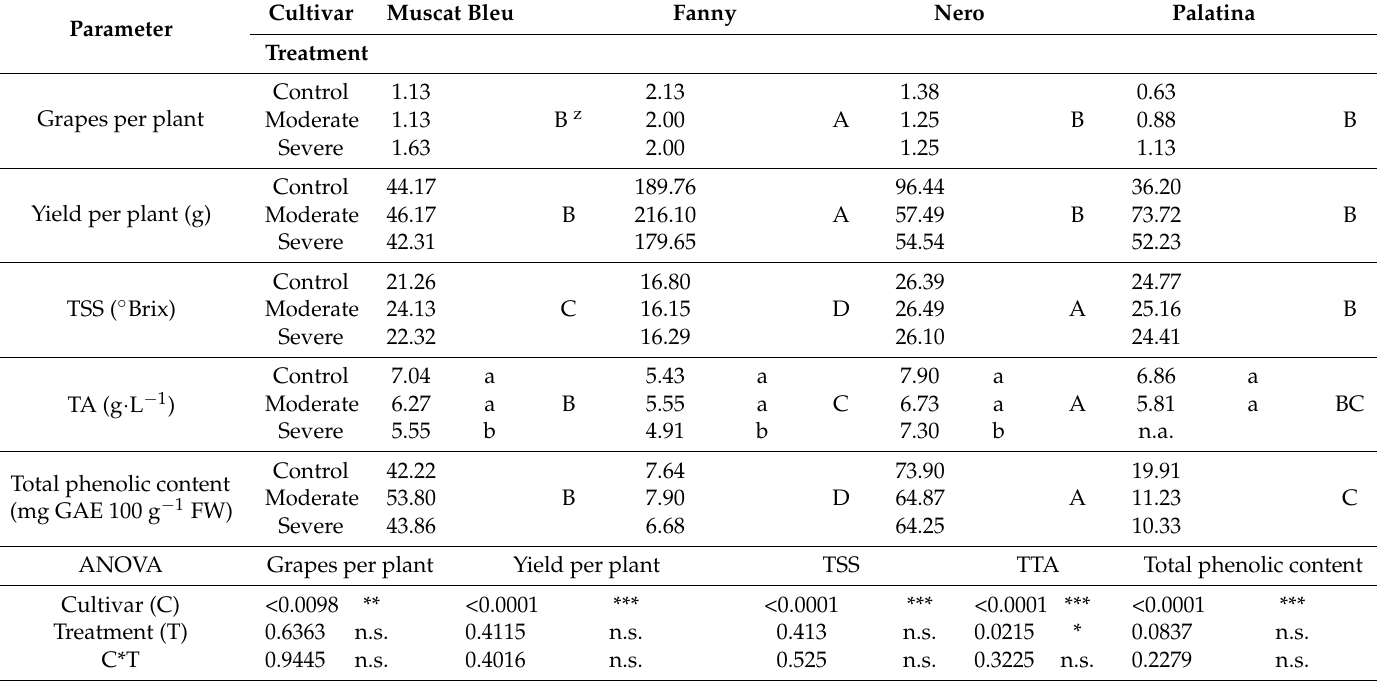
Table 1. Table grape parameters at the plant level: Number of bunches per plant, yield per plant, TSS, TA, and total phenolic content of four three-year-old table grape cultivars under three water deficit treatments in